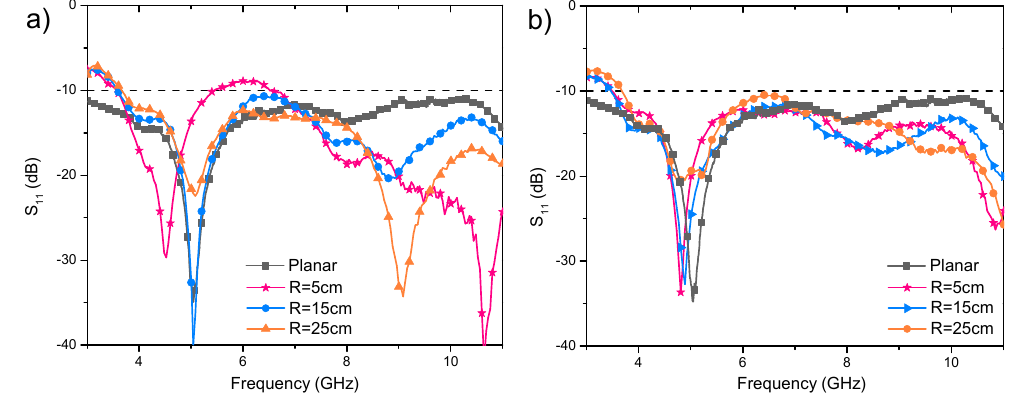
Figure 7. The return loss graphs of the proposed antenna under bending along ( a ) the X-axis and ( b ) the Y-axis.